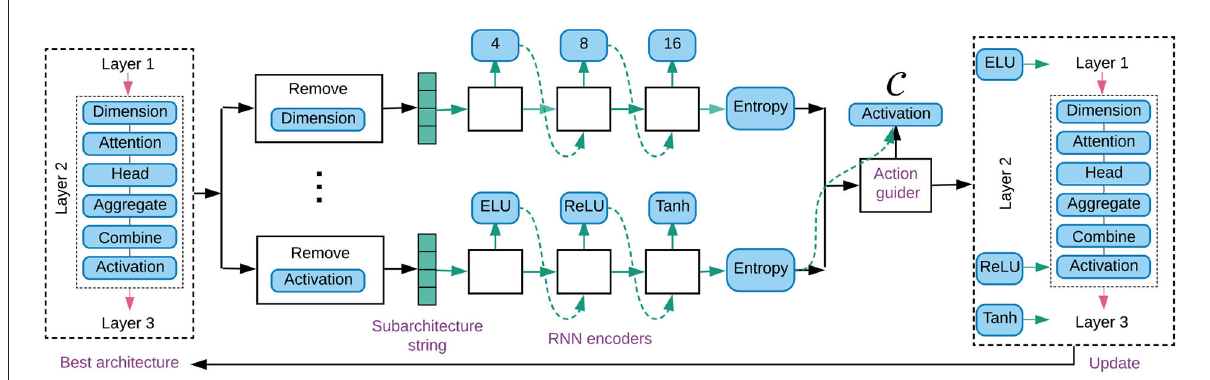
FIGURE1 Illustration of AGNN with a three-layer GNN search along elementary dimensions. Controller takes the best architecture as input, and applies RNN encoder to sample the alternative modules for each dimension. We select the dimension (e.g., activation function) deserved to be explored, and modify the preserved best architecture with the alternative